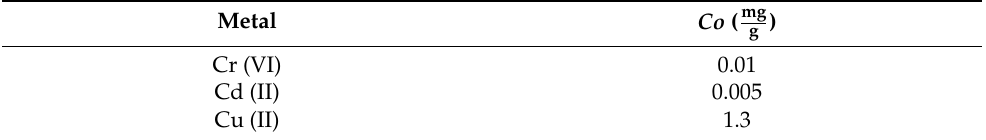
Table 1. Permitted concentration limit [30].